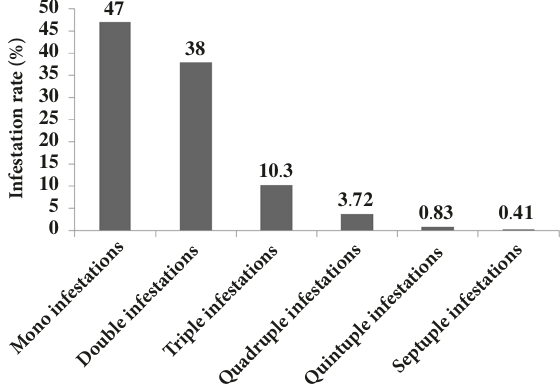
Figure 2: Occurrence of polyparasitism in indoor pigs in Bam- boutos, Cameroon.